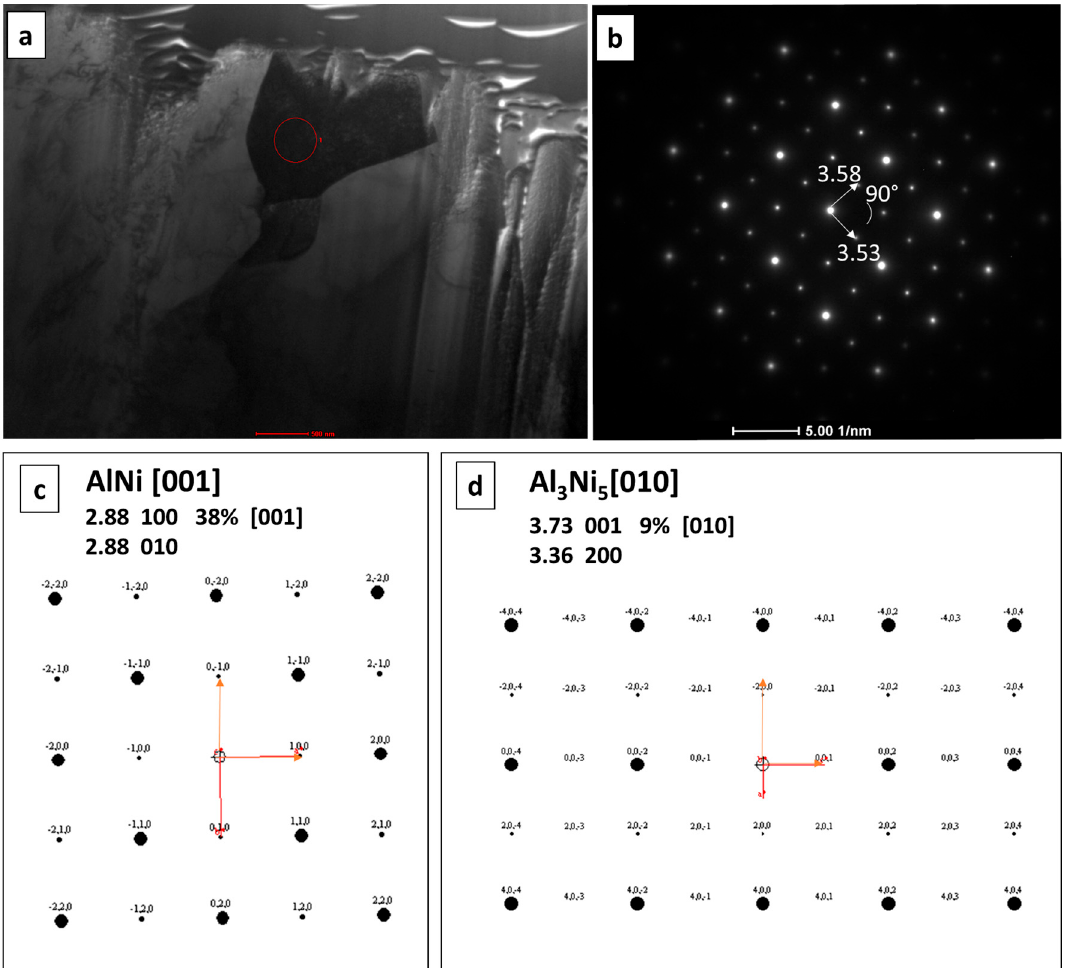
Figure 10. ( a ) TEM bright field image showing the microstructure of the AlNi intermetallic phase for sample annealled for 3 h at 720 °C together with the corresponding ( b ) selected area diffraction pattern taken from the grain marked with circle. Simulation of the solve for ( c ) AlNi and ( d ) Al 3 Ni 5 .